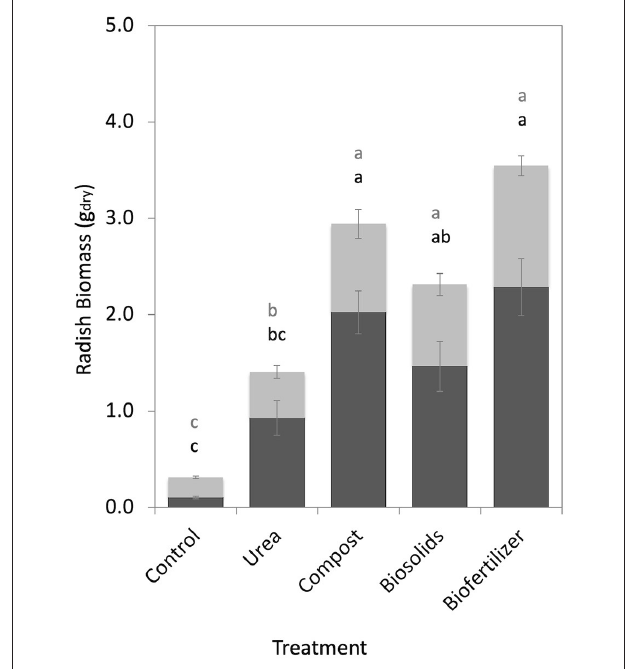
FIGURE 1 | Total plant biomass of the first crop of radishes grown in pots with soils with amendments derived from human excreta, compared to a synthetic N-based fertilizer (urea) and an unamended/unfertilized control. Light bars represent treatment means of dry aboveground biomass, and dark bars represent treatment means of dry belowground biomass. Error bars indicate ± standard error for each biomass component. Differences in lightly shaded letters indicate significant treatment differences for aboveground biomass, whereas darker letter indicate treatment difference of belowground biomass, as determined by an ANOVA and post hoc Tukey means comparison test with significance determined as p < 0.05.